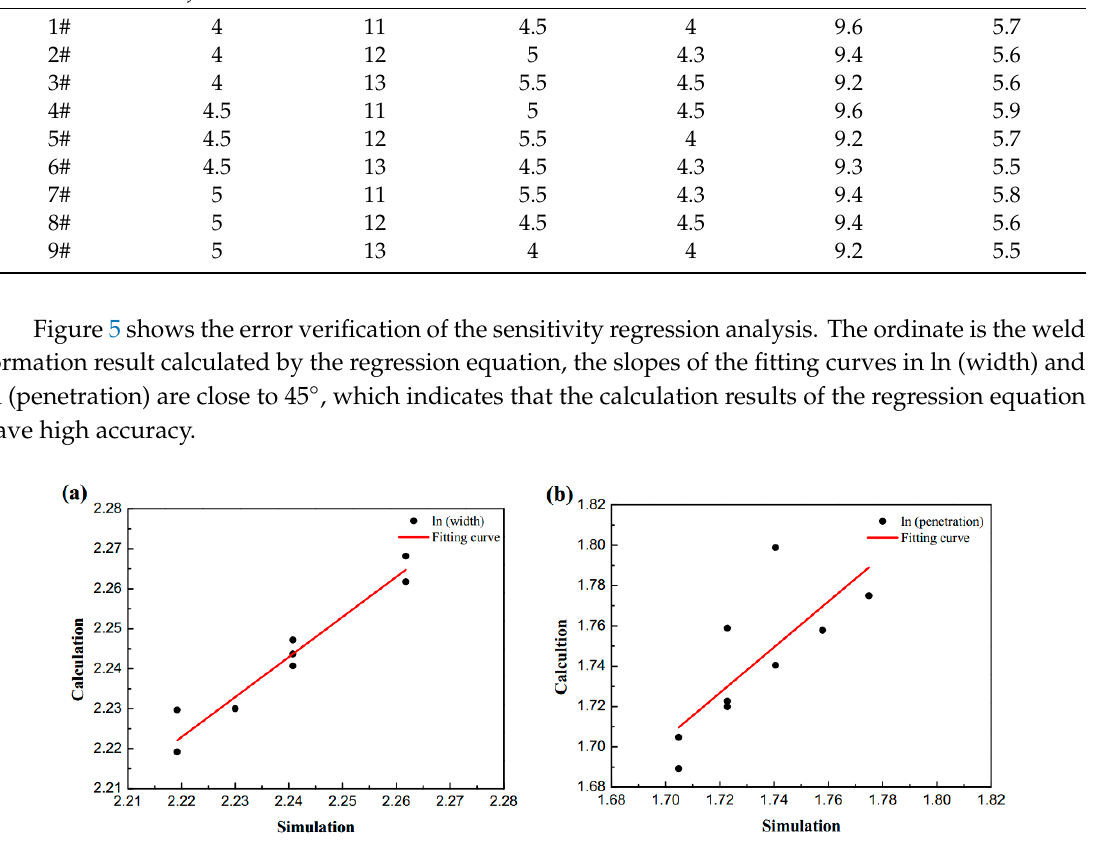
Table 3. The weld pool size results of heat source parameters sensitivity analysis. Sample